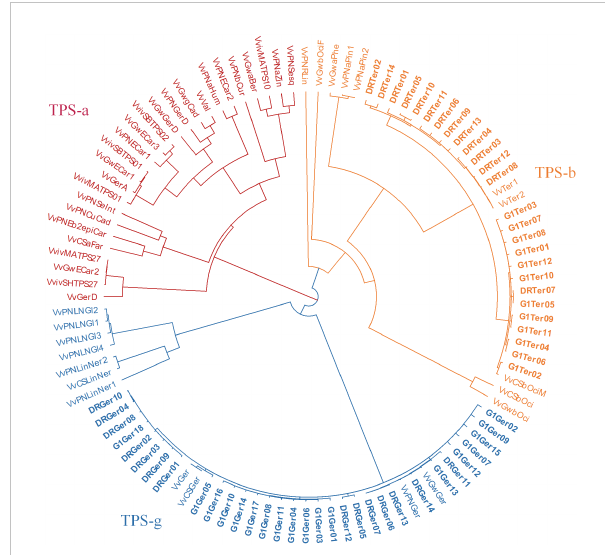
FIGURE 7 Phylogenetic tree (nucleotide sequences of coding regions) of ‘ Deckrot ’ and G1-7720 ’ s VvTer and VvGer gene copies compared to functionally characterised V. vinifera terpene synthase genes. Clusters are coloured according to which TPS-subfamily the genes fall under. “ G1 ” and “ DR ” indicate cultivar origin of isolated gene (G1- 7720 and ‘ Deckrot ’ ,